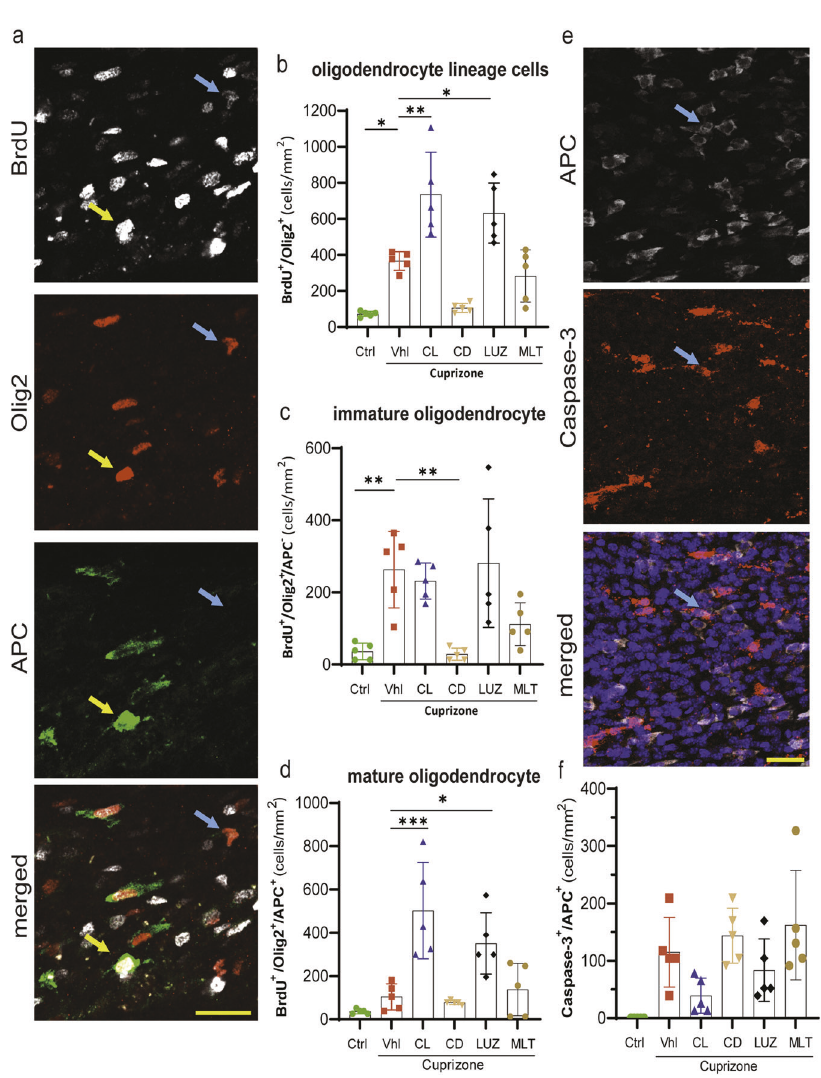
Fig. 3 Quanti fi cation of the oligodendroglial response to demyelination and treatment in the corpus callosum. a Fluorescent staining of newly generated BrdU + cells. Olig2 is a marker of the oligodendroglial lineage. APC is a marker of mature oligodendrocytes. DAPI staining of the nucleus. Left panel, the blue arrow shows immature OLs, and the yellow arrow shows mature OLs. b Quanti fi cation of the oligodendroglia lineage (BrdU + /Olig2 + cells), which includes both immature and mature OLs. c Quanti fi cation of immature OLs (OPCs; BrdU + /Olig2 + /APC- cells). d Quanti fi cation of mature OLs (BrdU + /Olig2 + /APC + cells). e Costaining of the apoptosis marker Caspase-3 and the oligodendrocyte marker APC. Right panel: The arrow indicates Caspase-3 colocalization with APC. f Quanti fi cation of the mean number of Caspase-3 + / APC + cells. All quanti fi cations were performed in the middle corpus callosum along the rostrocaudal axis. ( n = 5 mice/group; 3 slides per mouse). Signi fi cance is indicated by ∗ p < 0.05; ∗∗ p < 0.01; and ∗∗∗ p < 0.001. Scale bars, 20 μ cortisol were observed when melatonin receptors were stimulated with exogenous melatonin or inhibited with the antagonist luzindole (Fig. 1b, c).